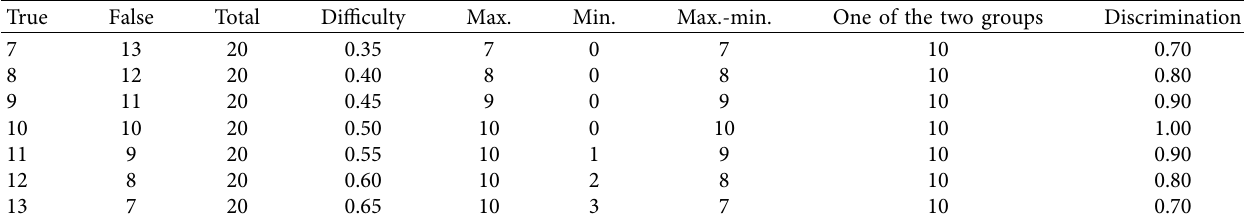
Table 2: The arithmetic coefficients to extract the discrimination coefficient for the basic science process test questions. True False